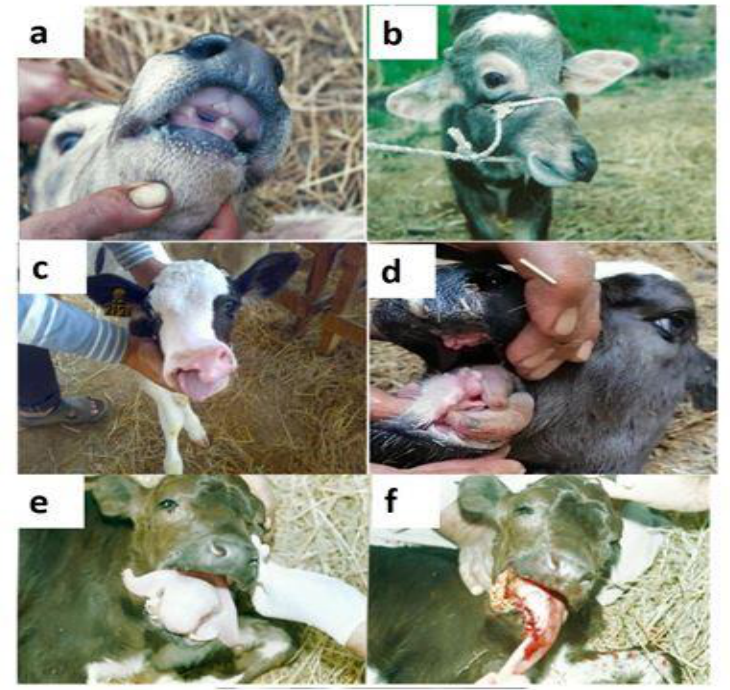
Fig. 2: Gross pictures showing congenital oral malformations in bovine calves: Brachygnathia inferior (parrot mouth) (a), campylognathia (curved jaw) (b), cheiloschisis (harelip) (c) and two cases of double tongue in Holstein calf (d) and in mixed breed calf before (e) and after surgical intervention (f).